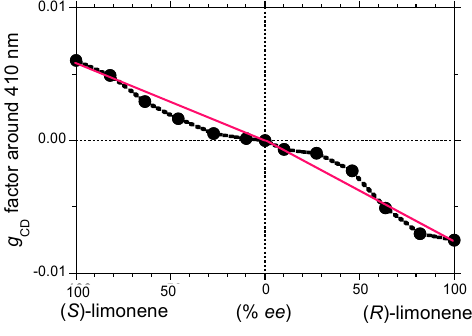
Figure 6. The g value at the 405 nm CD band of PF8P2 aggregates in CD chloroform/limonene/ methanol = 0.3/1.1/1.6 (v/v/v) as a function of limonene % ee